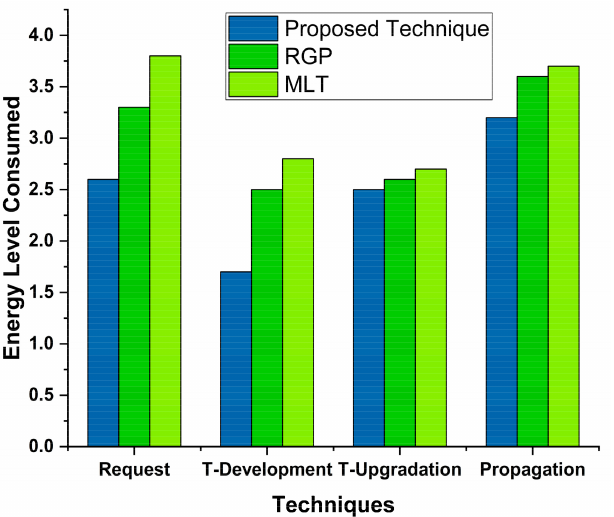
Figure 12. Power consumption while task offloading.